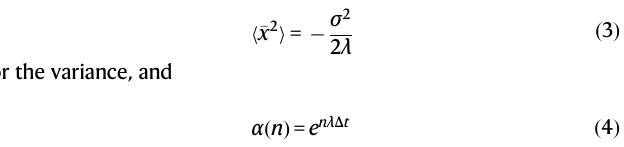
( p >0.05) shown as a black circle. Additional box-plot of 1000 randomly sampled surrogates (box edges: 25 – 75th percentiles, black line:median) shown with redfor MODIS NDVI, orange for AVHRR NDVI 24 , and blue for VOD. KT of medians con- sistently higher than box plots due to random sampling (see Methods). Both VOD and NDVI exhibit lower resilience — i.e. λ closer to zero, see Methods — with lower water availability across the majority of land-cover types. While for all three con- sidered vegetation datasets empirical recovery rates generally decrease with more concentratedprecipitation,therelationshipbetweenWalsh-Lawlerseasonalityand recovery rates is less steep than for aridity (Fig. 3). Figure showing all